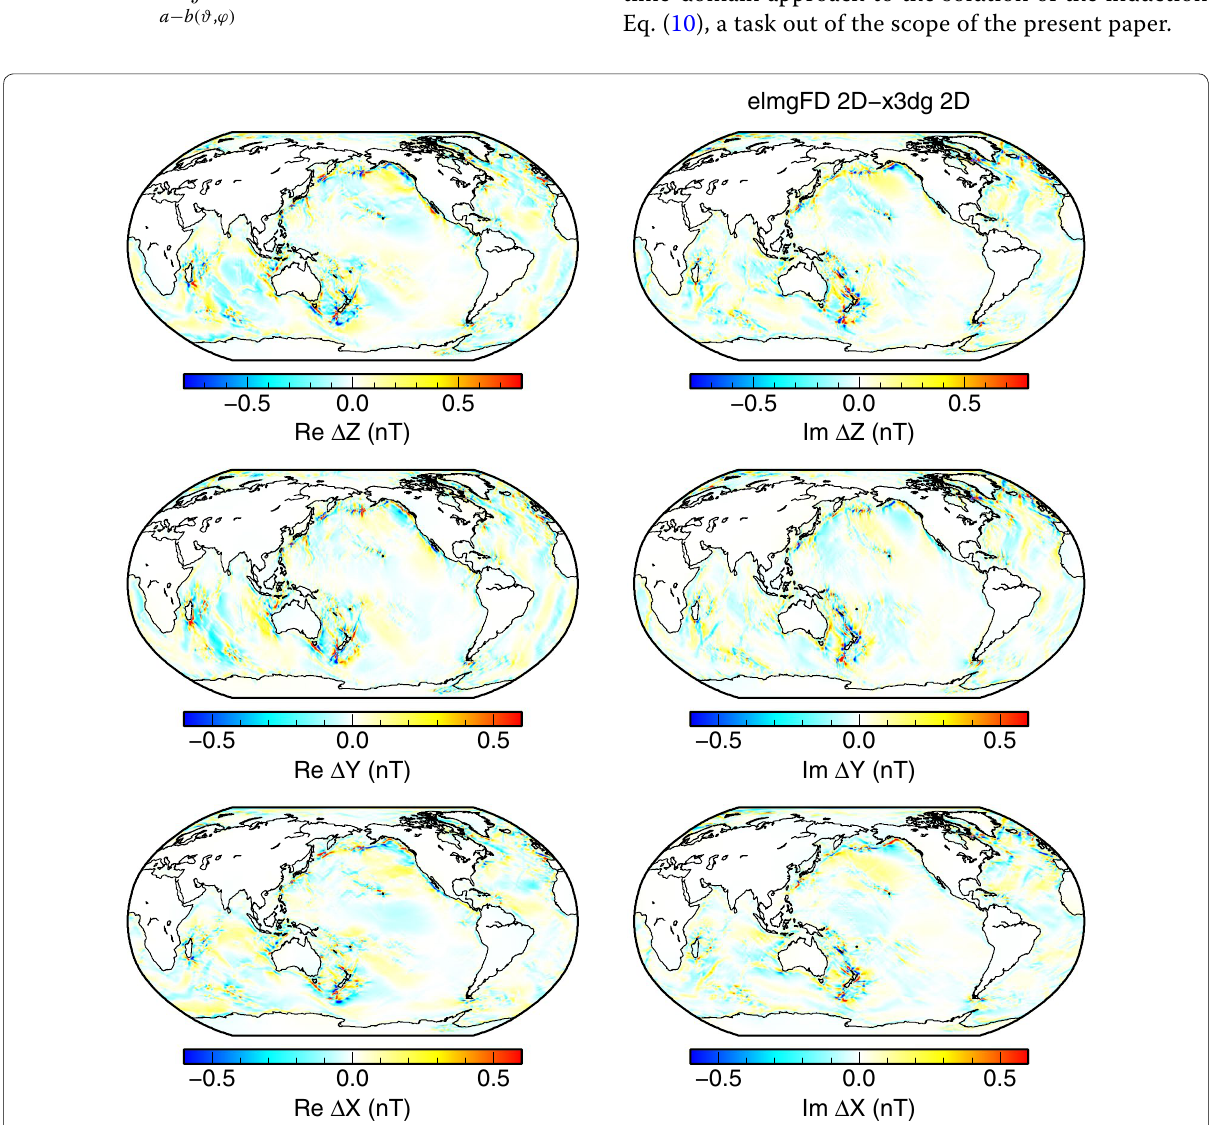
Fig. 5 Differences between elmgFD and x3dg codes. Differences between the 2-D solutions calculated by the respective codes at the Earth’s surface for the highest resolution, j max = 480 and 0.25 ◦ × 0.25 ◦ , respectively. Note that the colour scales in Figs. 5, 6, 7 and 9, 10 are reduced with respect to Fig.